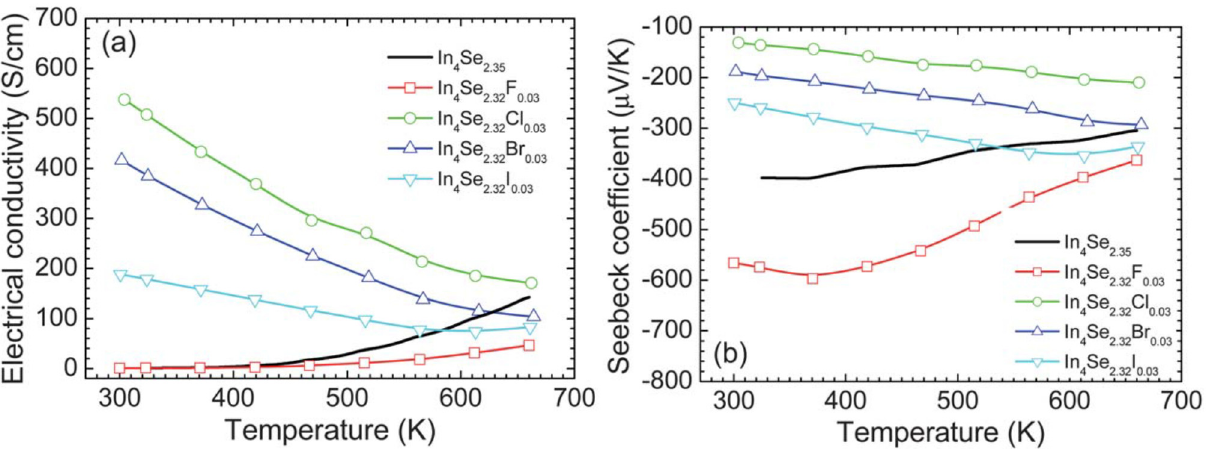
Figure 16. Temperature dependence of ( a ) electrical conductivity and ( b ) Seebeck coefficient of the crystals of In 4 Se 3 − x H 0.03 ( x = 0.68; H = F, Cl, Br, I) and In 4 Se 2.35 [32].